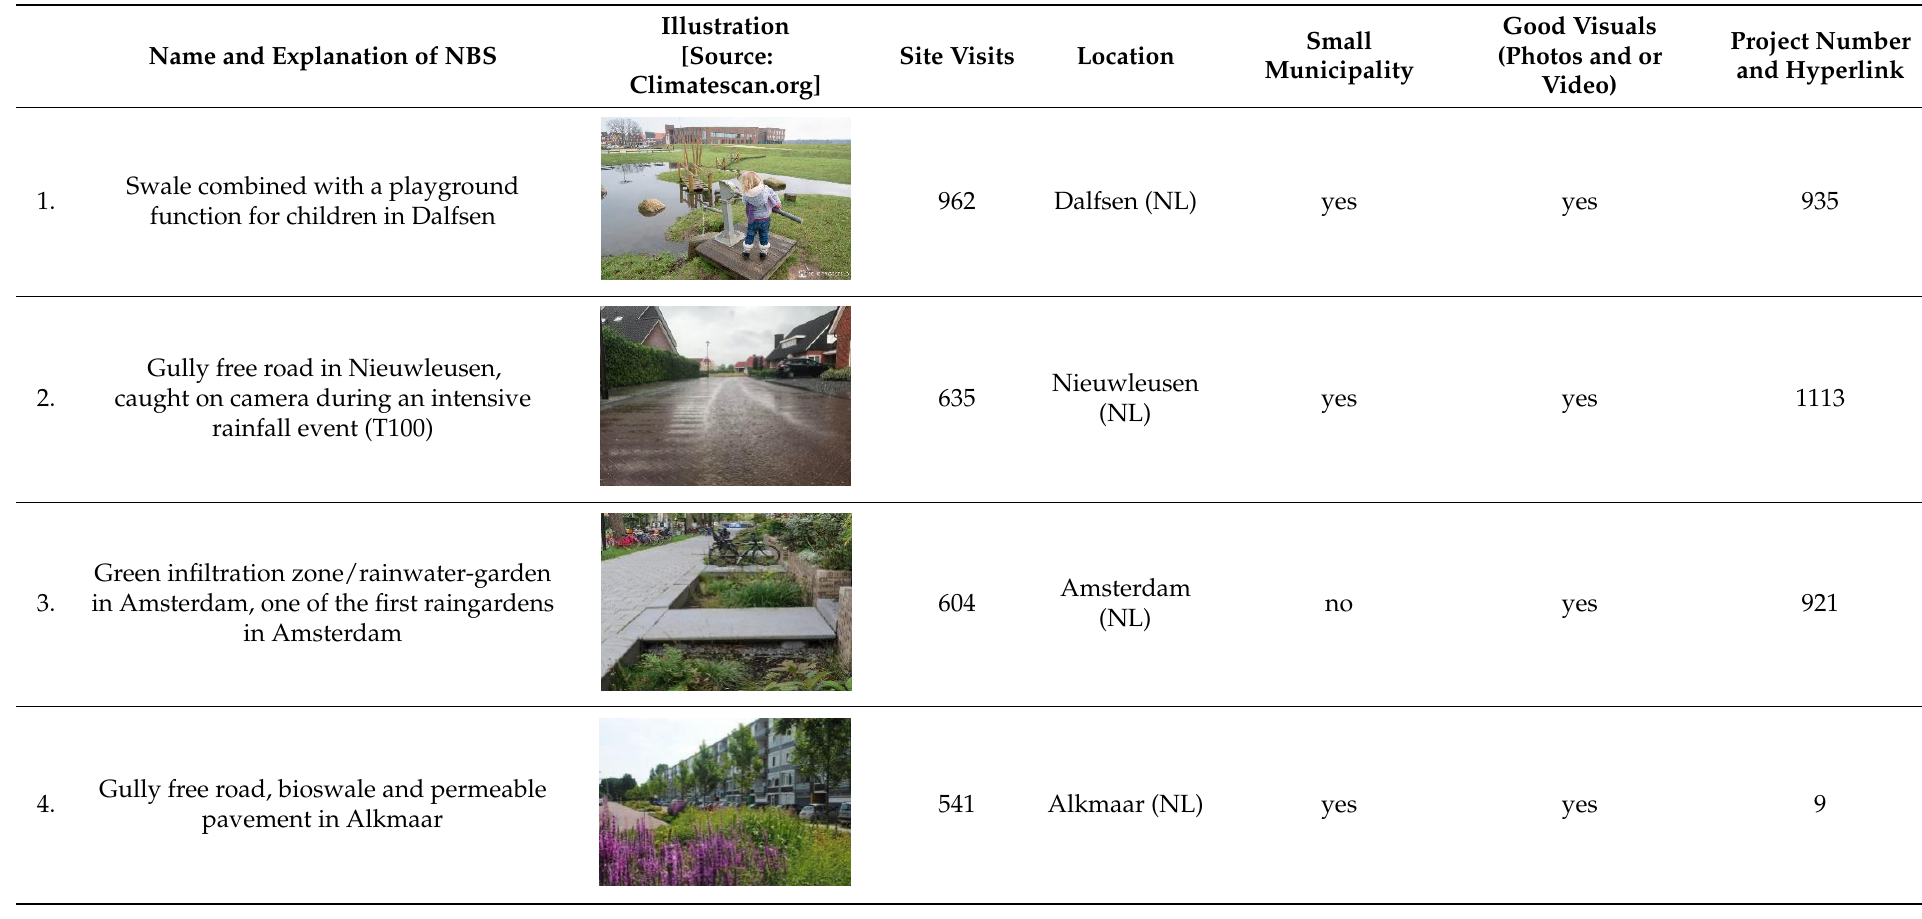
Table 2. Top 15 most visited projects on the ClimateScan platform (based on project site visits retrieved from Google Analytics).